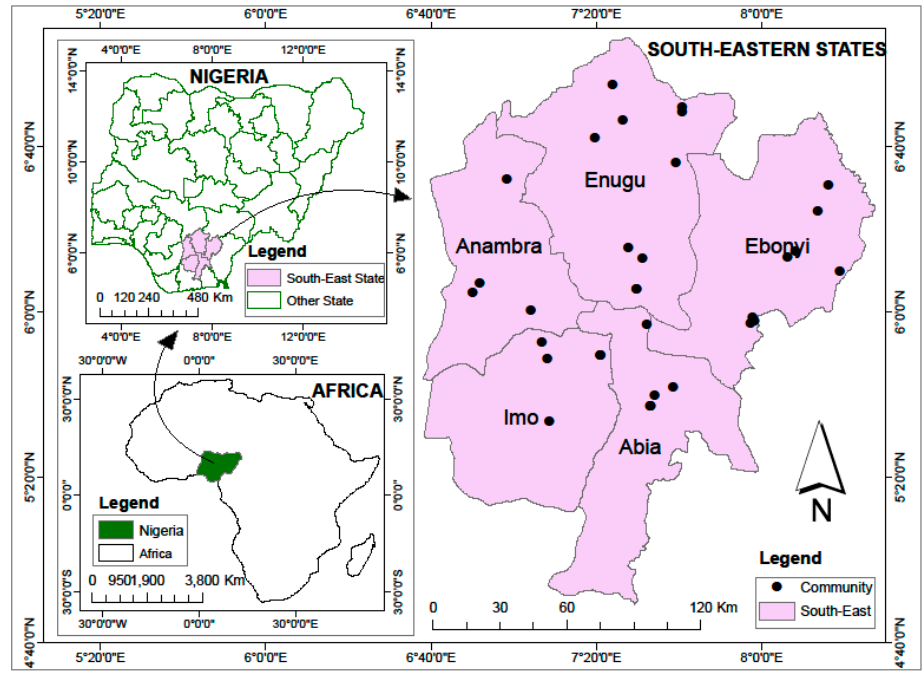
Figure 10. Data collection sites for Sphenostylis stenocarpa in southeast